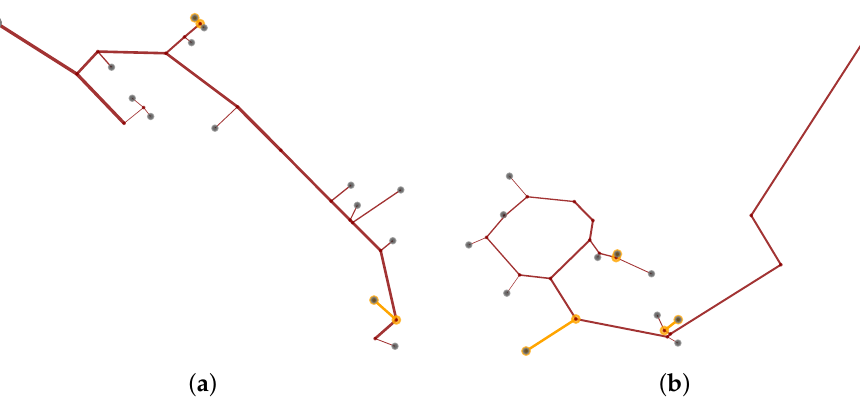
Figure 9. Bottlenecks (highlighted in orange) in the separated district heating networks of the FZJ use-case. ( a ) Separated network scenario 2; ( b ) Separated network scenario